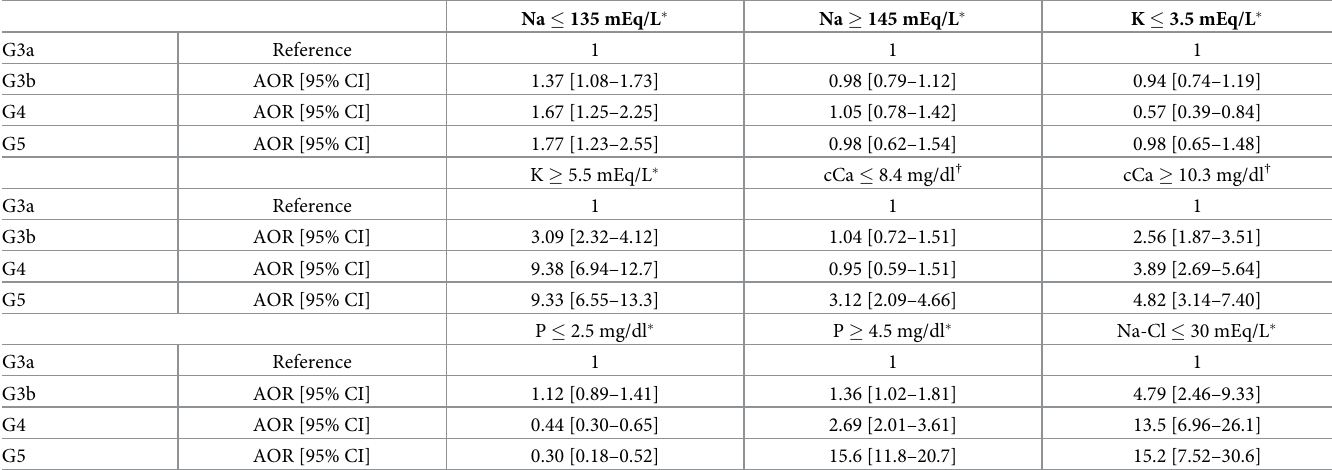
Table 6. Adjusted odds ratios and 95% confidence intervals for electrolyte disorders according to G category